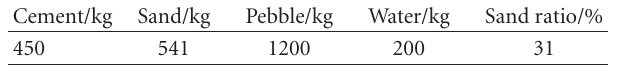
Table 1: Mix proportion of the concrete.